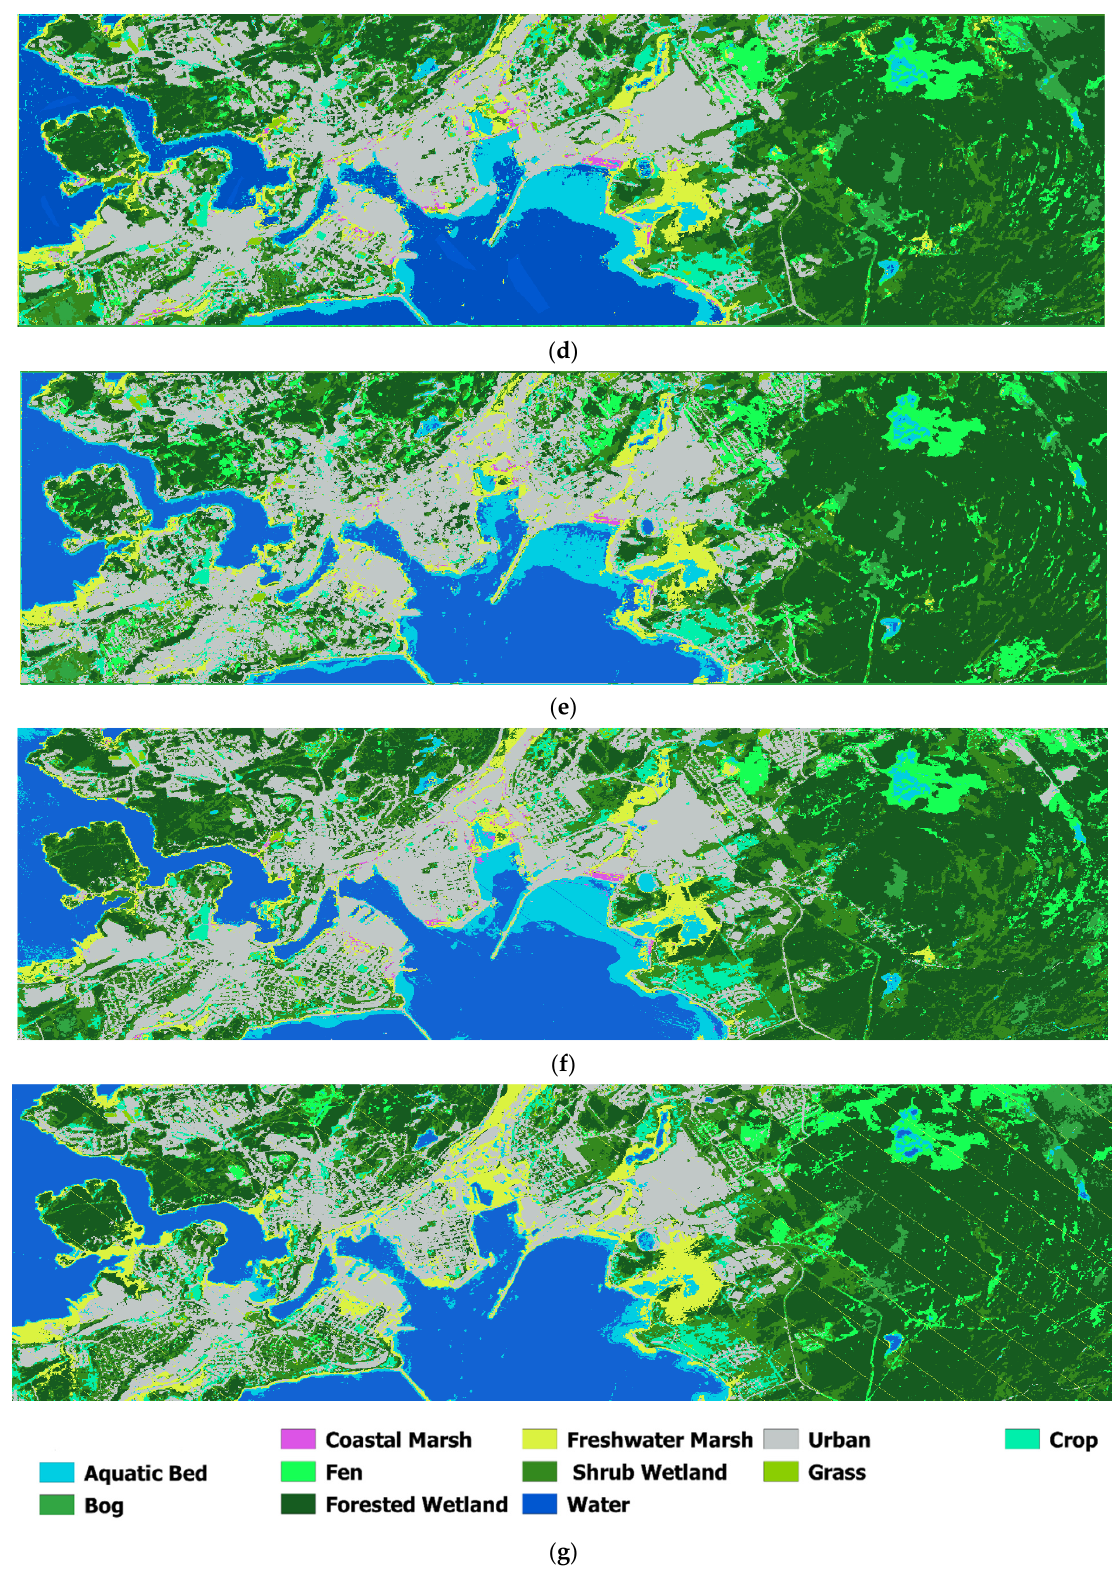
Figure 6. ( a ) The Sentinel-2 true color of the pilot site of Saint John city, ( b ) coastal wetland classifica- tion maps using the proposed multi-model deep learning algorithm, ( c ) Swin Transformer, ( d ) 3D CNN, ( e ) VGG-16, ( f ) random forest, and ( g ) support vector